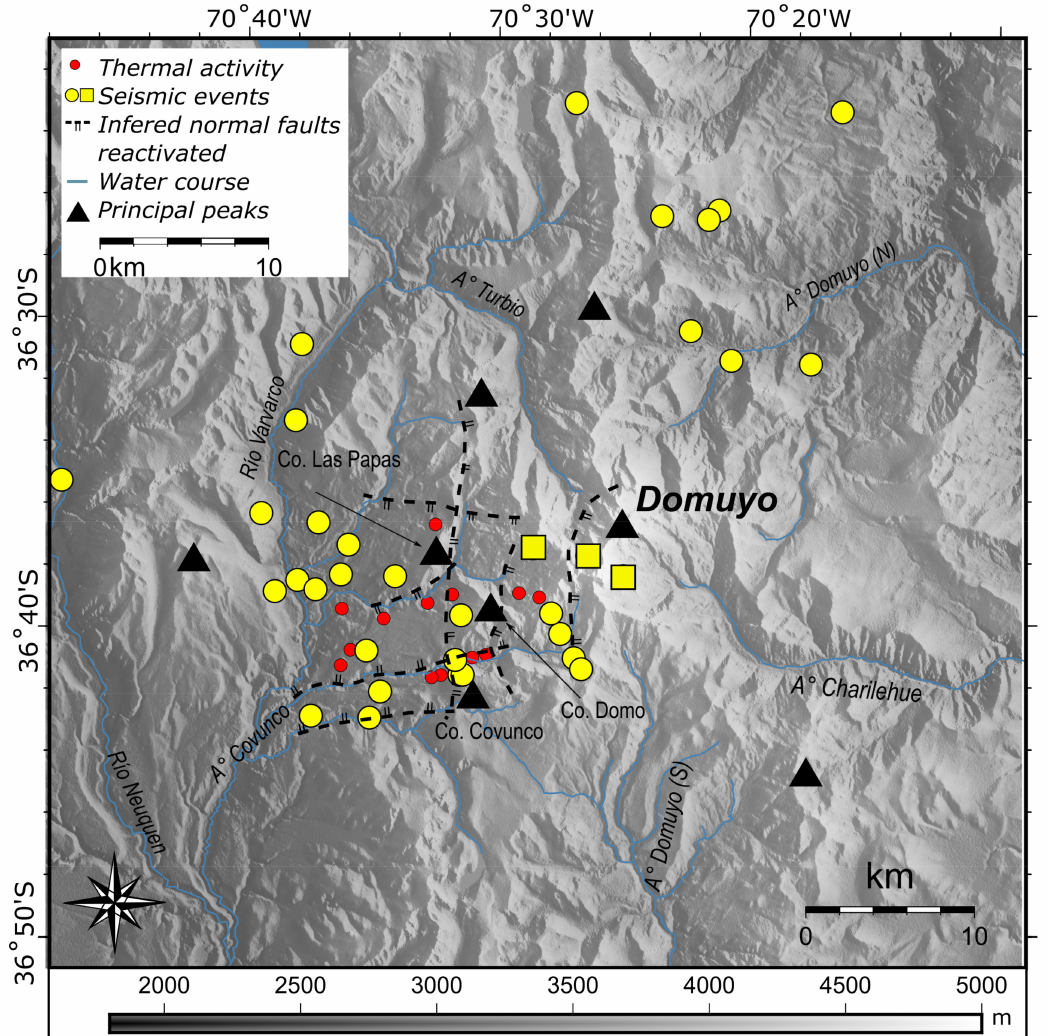
Figure 3. Yellow dots and squares indicate the measured seismic events over the DVC area (yellow squares represent a group of seismic events located over the summit of the DVC). The black dashed lines correspond to identified neotectonic extensional faults [20]. Red dots indicate associated thermal